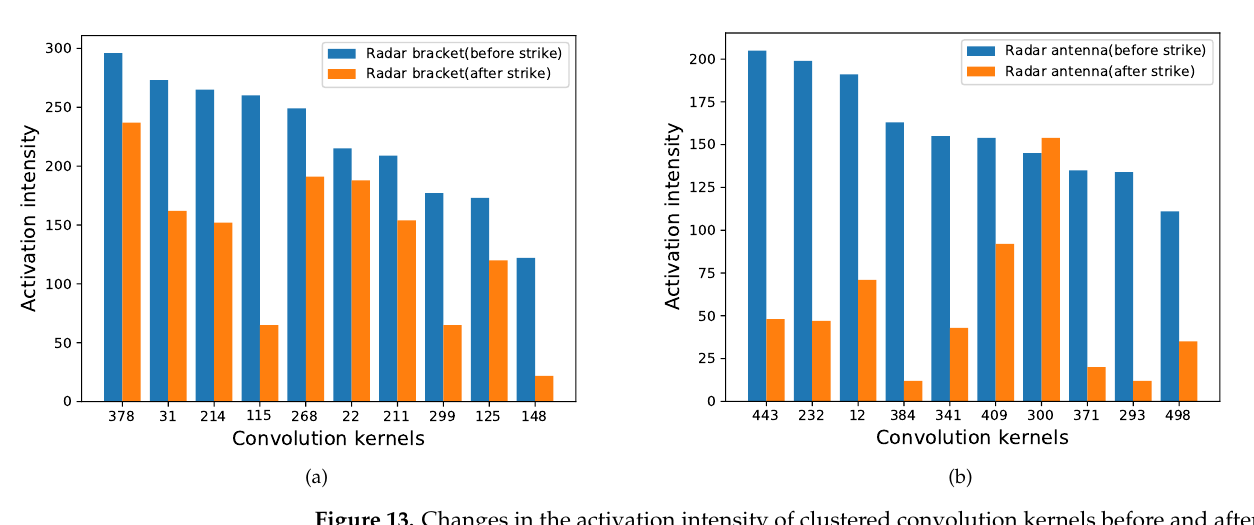
Figure 13. Changes in the activation intensity of clustered convolution kernels before and after the strike. ( a ) Radar bracket. ( b ) Radar antenna.